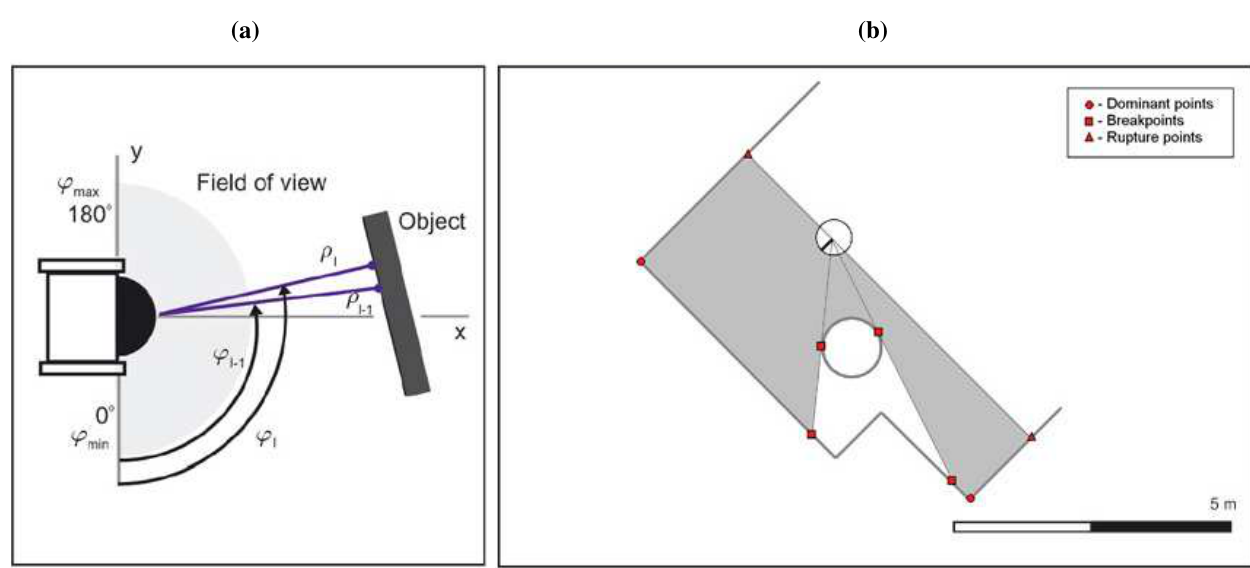
Figure 2. (a) Scan reference frame variables. (b) Problem